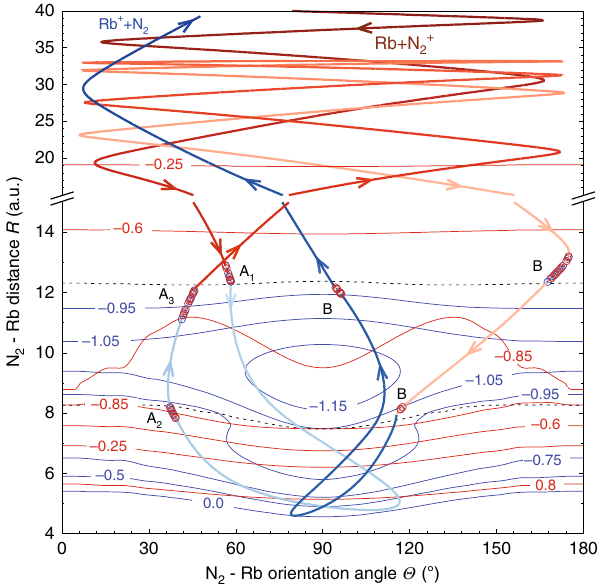
Fig. 8 Charge-transfer dynamics. Detailed dynamics of the trajectory shown in Fig. 7b, d represented as a projection onto the two coupled potential- energy surfaces (PES). Contour diagrams of the two PESs are shown as solid red (upper state) and blue (lower state) lines. Contour lines are labelled in eV. The avoided crossing regions are shown as black dashed lines. Thick red and blue lines show the trajectory path on the upper and lower surface, respectively. The progress in time of the trajectory is represented as a change in colour from dark to light (for the upper state) and light to dark (for the lower state) colour tones. Hops between surfaces are indicated as red and blue open circles in regions labelled identically to 7b,